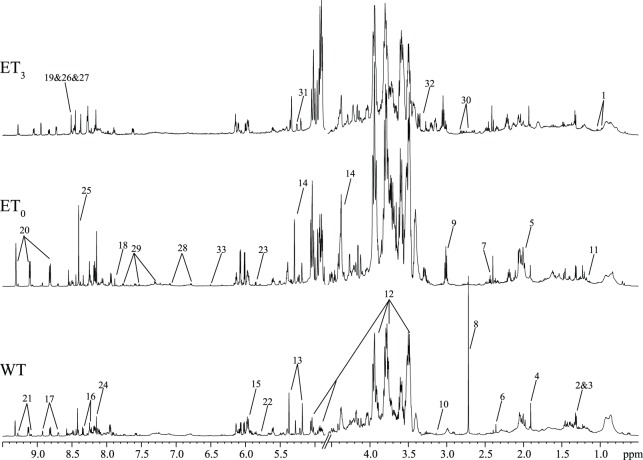

1H NMR spectra of the intracellular polar metabolites of C. thermocellum.The spectra of the wild type strain (WT) and the ethanol-tolerant strain without additional ethanol (ET0) and with 3% ethanol (ET3) were shown from bottom to top. The left halves (4.90–9.50 ppm) of all spectra are magnified two times in the Y-axis for clarification. Keys: 1, valine; 2, lactic acid; 3, threonine; 4, acetic acid; 5, glutamate; 6, pyruvate; 7, succinate; 8, dimethylamine; 9, norspermidine; 10, malonate; 11, ethanol; 12, cellodextrin; 13, phosphoenolpyruvate; 14, L-erythrose; 15, uridine monophosphate; 16, adenosine; 17, nicotinate; 18, thymidylic acid; 19, Adenosine monophosphate; 20, nicotinamide adenine dinucleotide; 21, nicotinamide adenine dinucleotide phosphate; 22, uracil; 23, uridine monophosphate; 24, inosine; 25, formate; 26, adenosine diphosphate; 27, adenosine triphosphate; 28, tyrosine; 29, tryptophan; 30, aspartate; 31, α-arabinose; 32, methanol; 33, fumarate; 34, guanine; 35, cytosine; 36, acetamide; 37, p-aminobenzoic acid; 38, uridine diphosphate glucose; 39, α-D-galactose-1-phosphate.